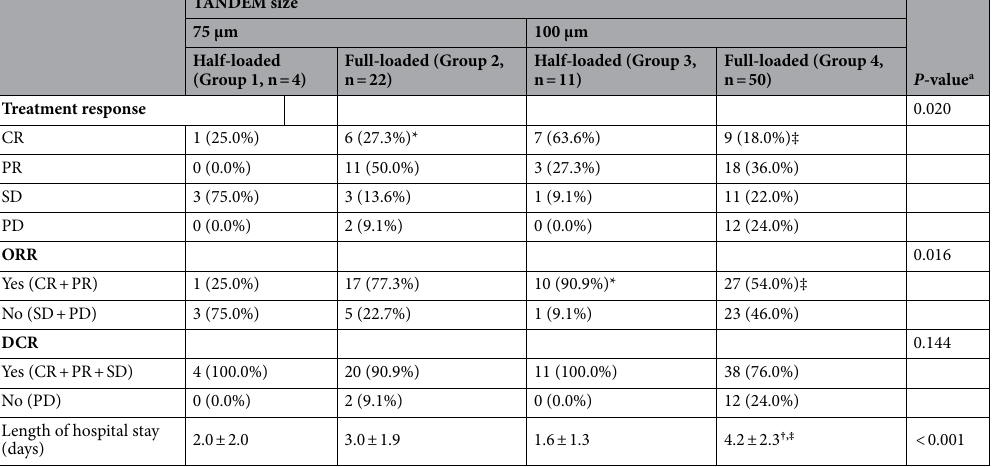
Table 7. Statistics of treatment response and length of hospital stay stratified by both TANDEM size and drug- loading concentration. Treatment response, ORR and DCR were resented as number and percentage. Length of hospital stay were presented as mean ± SD (days). a Fisher’s exact test and Kruskall-Wallis test was performed for treatment response and length of hospital stay, respectively. * P < 0.05 compared to Group 1 by Fisher’s exact test for treatment response and Mann–Whitney test for length of hospital stay. † P < 0.05 compared to Group 2 by Fisher’s exact test for treatment response and Mann–Whitney test for length of hospital stay. ‡ P < 0.05 compared to Group 3 by Fisher’s exact test for treatment response and Mann–Whitney test for length of hospital stay. CR complete response, PR partial response, SD stable disease, PD progressive disease, ORR objective response rate, DCR disease control